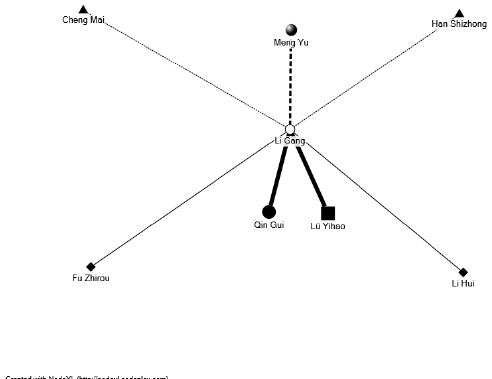
Figure 3. The Social Networks of Li Gang in 1131. The shape of the nodes denotes the mode of communication between Li Gang and his correspondents (triangle = poem; diamond = formal congratulatory note; circle = formal congratulatory note and letter; sphere = formal congratulatory note and poem; square = formal congratulatory note, letter, and poem). The size of the nodes and the thickness of the edges represents the number of formal congratulatory note, letter, and/or poems that Li Gang sent. Solid edge denotes that the correspondent was in Yuezhou while dotted edge denotes that the correspondent was in Fuzhou.